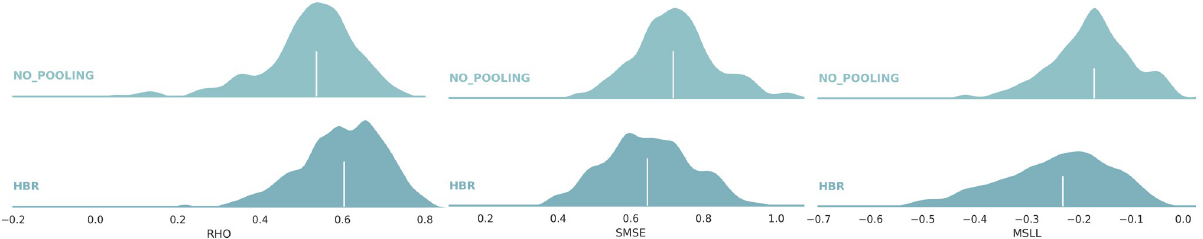
Fig 10. Comparing the regression performance of the adapted HBR model versus the no-pooling strategy. The ridge plots show distributions of correlation, SMSE, and MSLL across 148 cortical areas. The adapted HBR model shows a better regression performance compared to no-pooling.